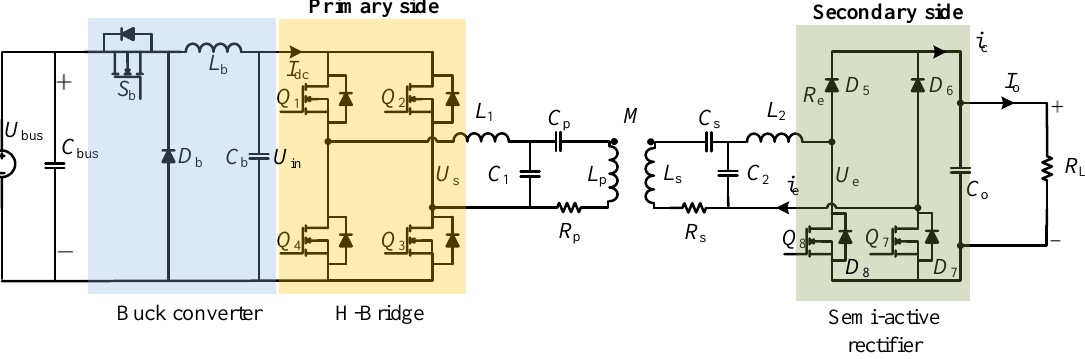
Figure 13. The structure of the LCC-LCC wireless power transfer system with 3.3 kW power level. Table 1. WPT system